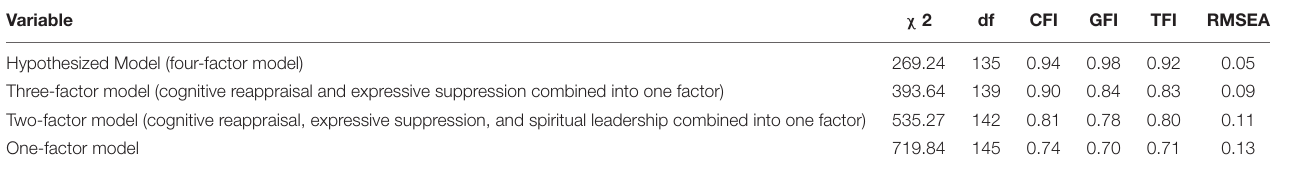
TABLE 2 | Results of confirmatory factor analyses ( N =